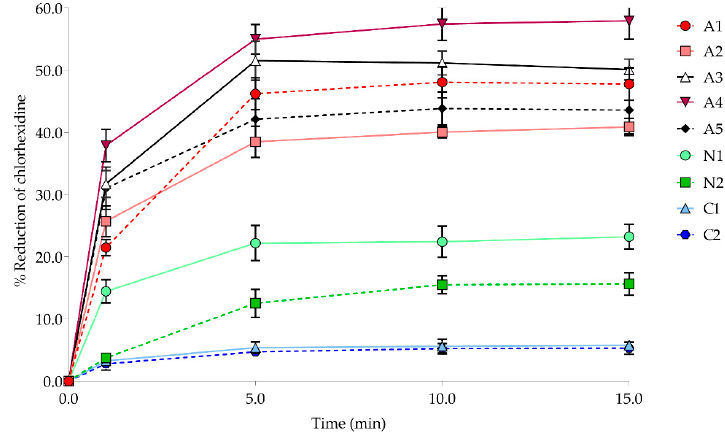
Figure 3. PercentreductioninCHGafterexposurewithlubricatinggelsat1, 5, 10, and15 min, respectively. Figure 3. Percent reduction in CHG after exposure with lubricating gels at 1, 5, 10, and 15 min, respectively.